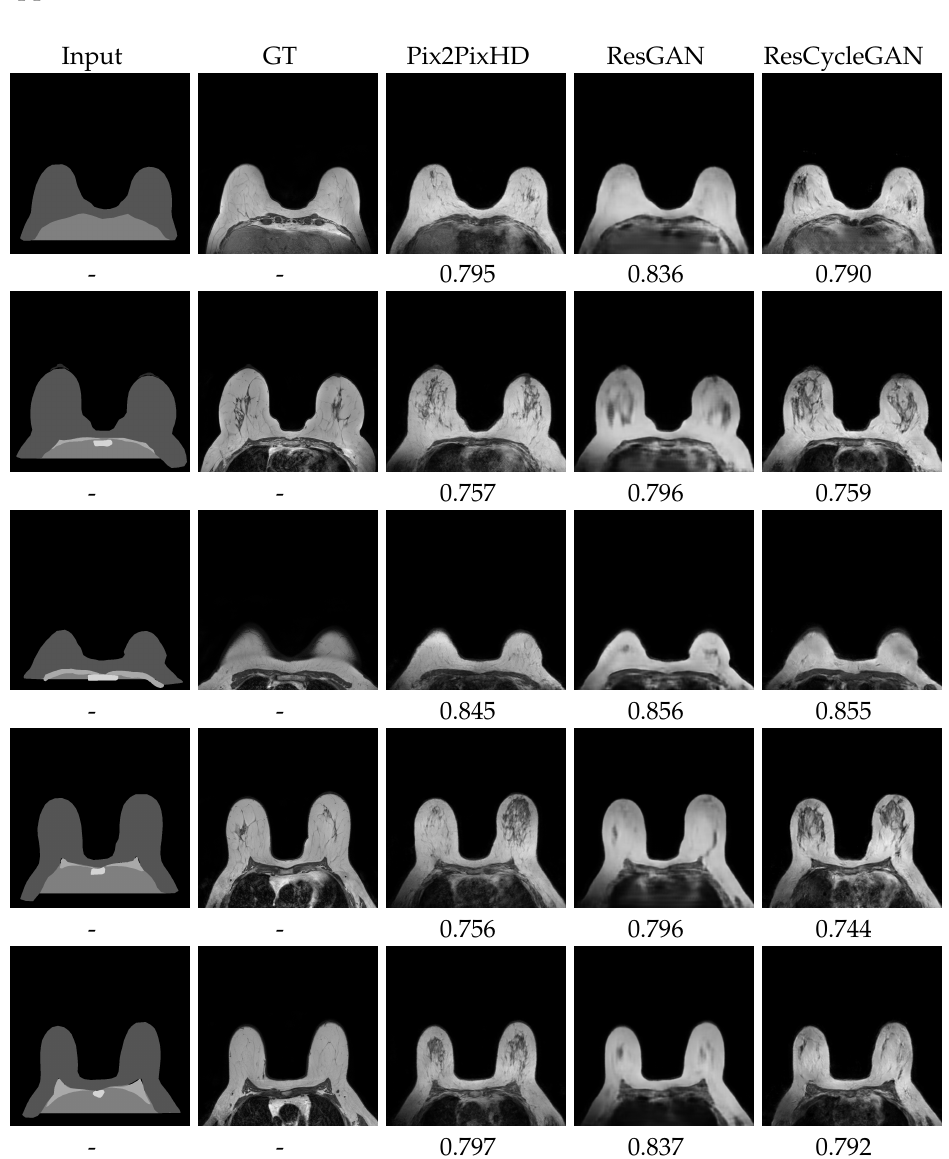
Figure A1. Further best visual test set generation results and respective SSIM. ResGAN and Pix2Pix- HD with BS8. CycleGAN with BS1 and Experience Replay. Part